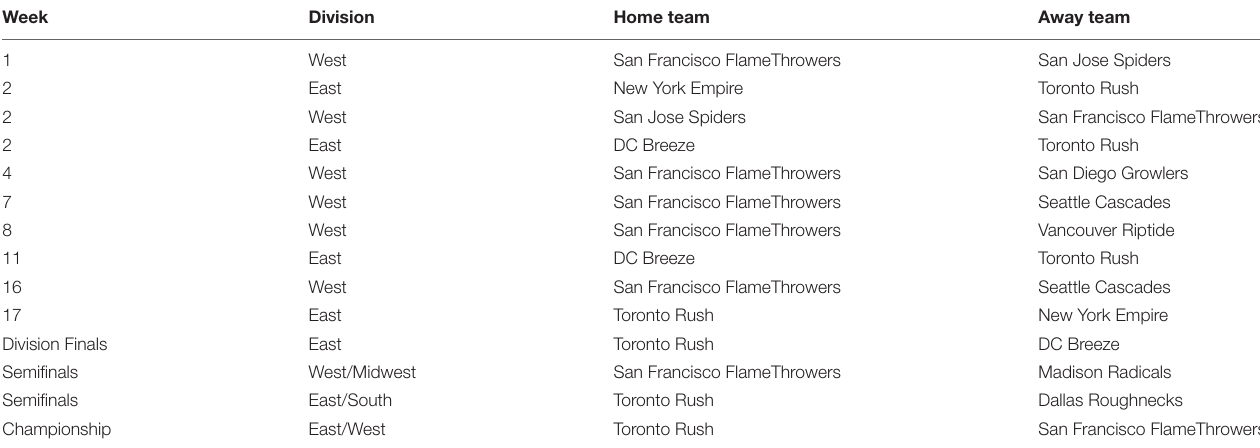
TABLE 1 | Sample entities from the 2017 AUDL